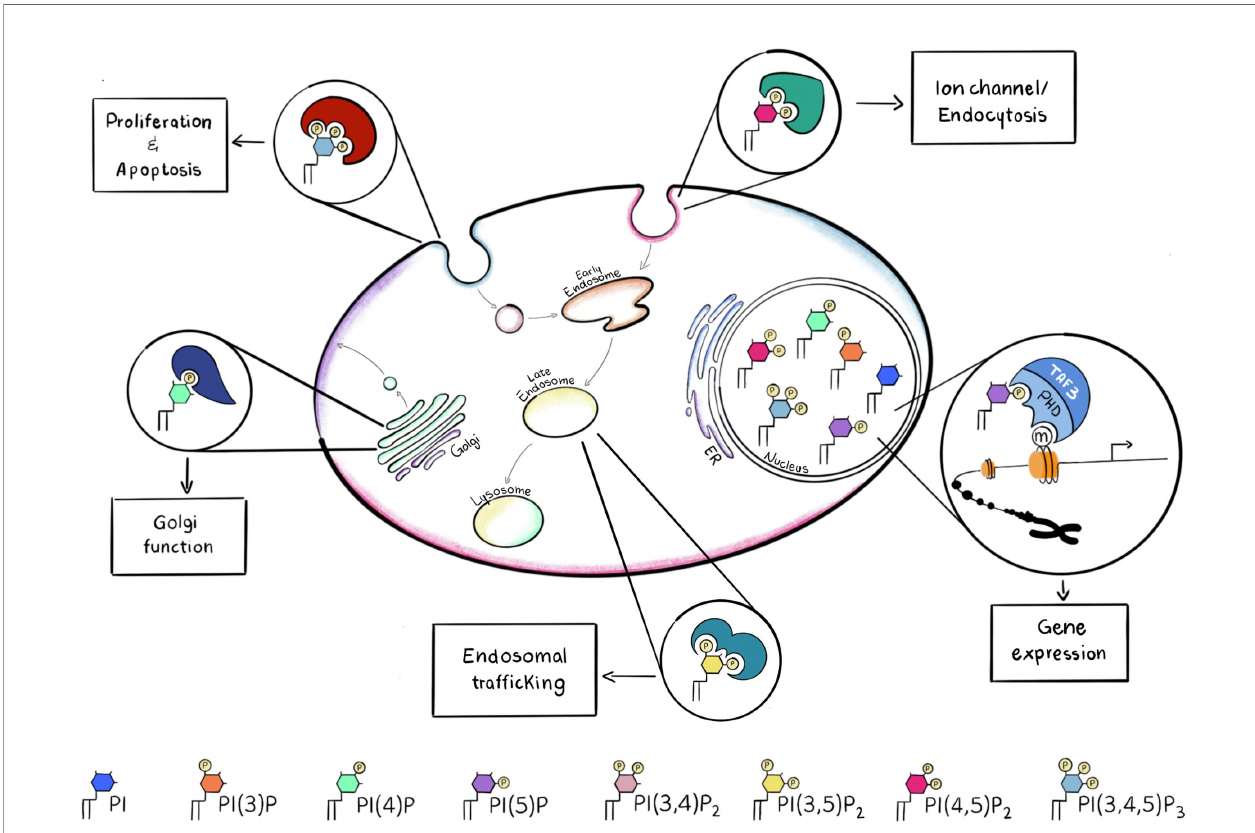
FIGURE 1 | PPIns may be phosphorylated on the 3, 4 and 5 positions to generate seven possible PPIns, each with a different spatial occupancy, that is recognized by different effector proteins. Recruitment of the necessary effector protein is guaranteed by the different accumulation of PPIns in the subcellular compartments. Here are some examples of how different PPIns interact with different effector proteins to convert chemical diversity into diverse functional